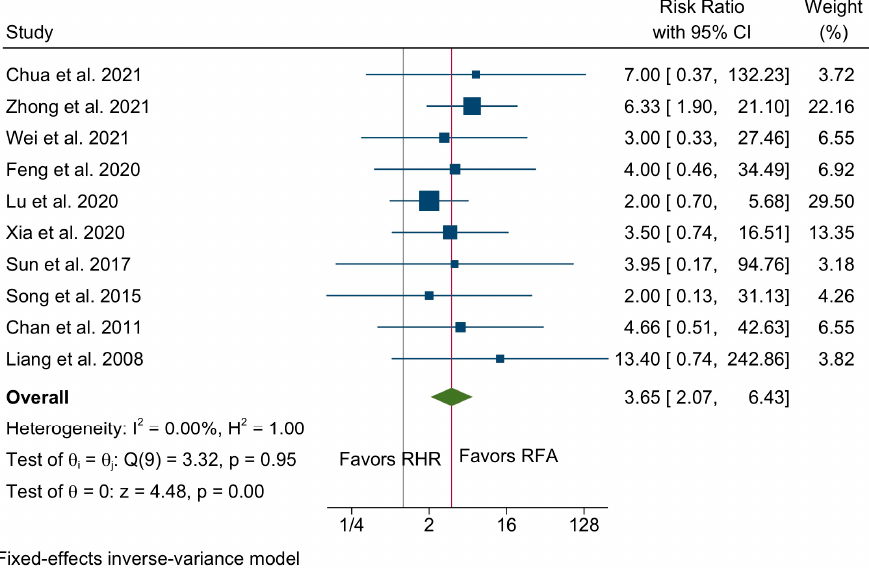
Figure 6. Forest plot of major morbidity between the RHR and RFA groups [22–24,27,29,30,32,34,36,38]. Data on post-procedural mortality were available in 12 studies with 2447 total patients (1024 in the RHR vs. 1423 in the RFA group, Table 3). Overall, six deaths were registered in the RHR group (0.5% mortality rate) and three in the RFA group (0.2% mortality rate), without any existing statistically significant difference between the two groups (RR 1.6,